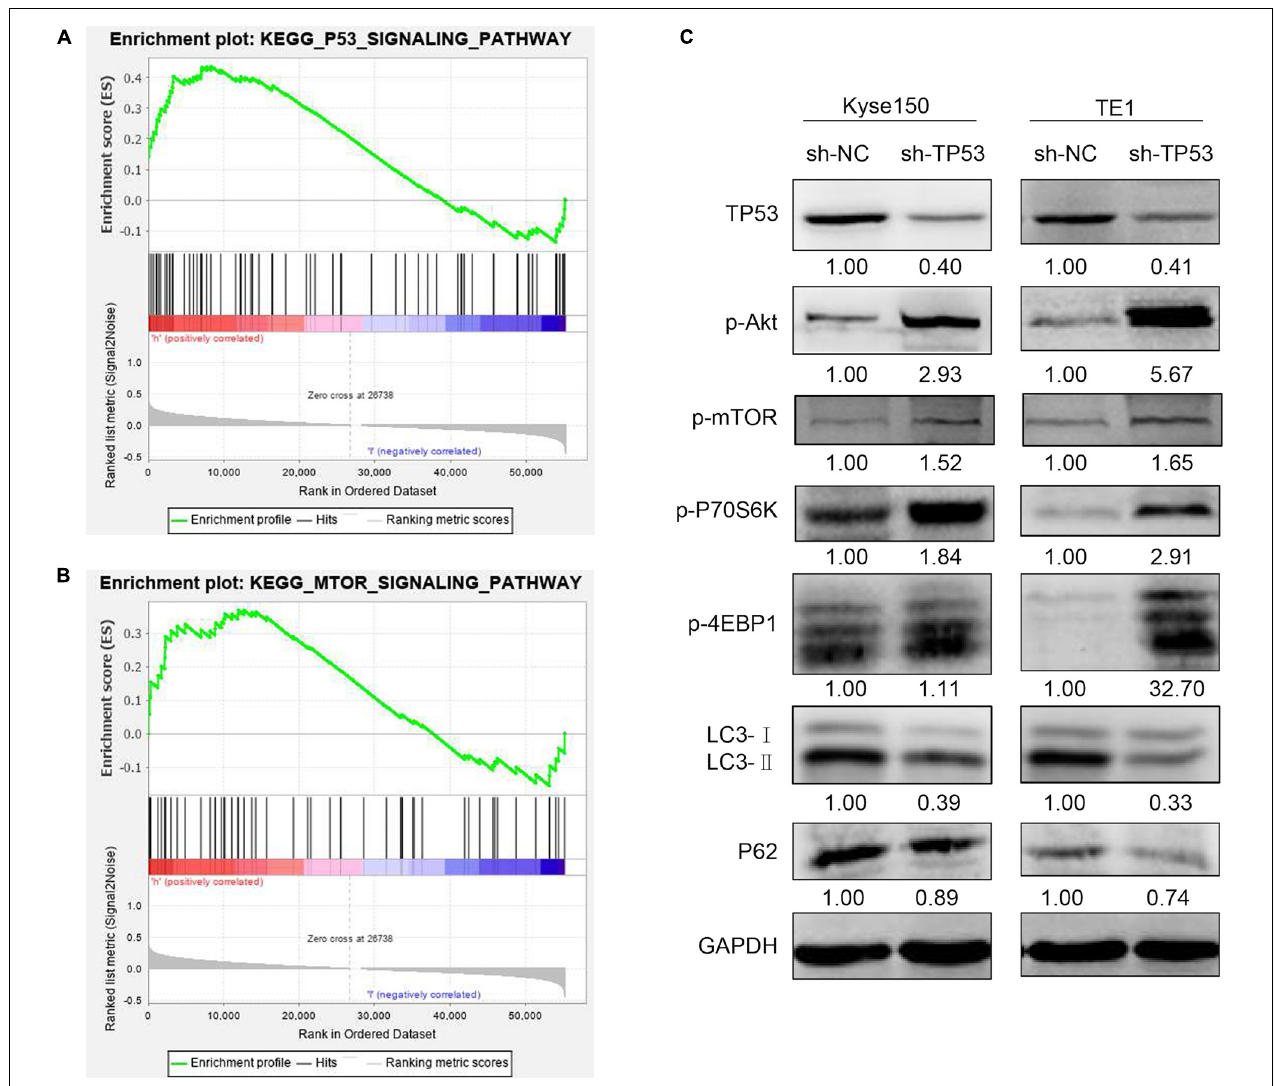
FIGURE 7 | TP53 regulated mTOR signaling pathway in ESCC cells. GSEA enrichment plots demonstrated that TP53 was positively correlated with the TP53 signaling pathway and mTOR signaling pathway (A,B) . Western blotting analysis of the mTOR signaling pathway- and autophagy-associated proteins (C) .